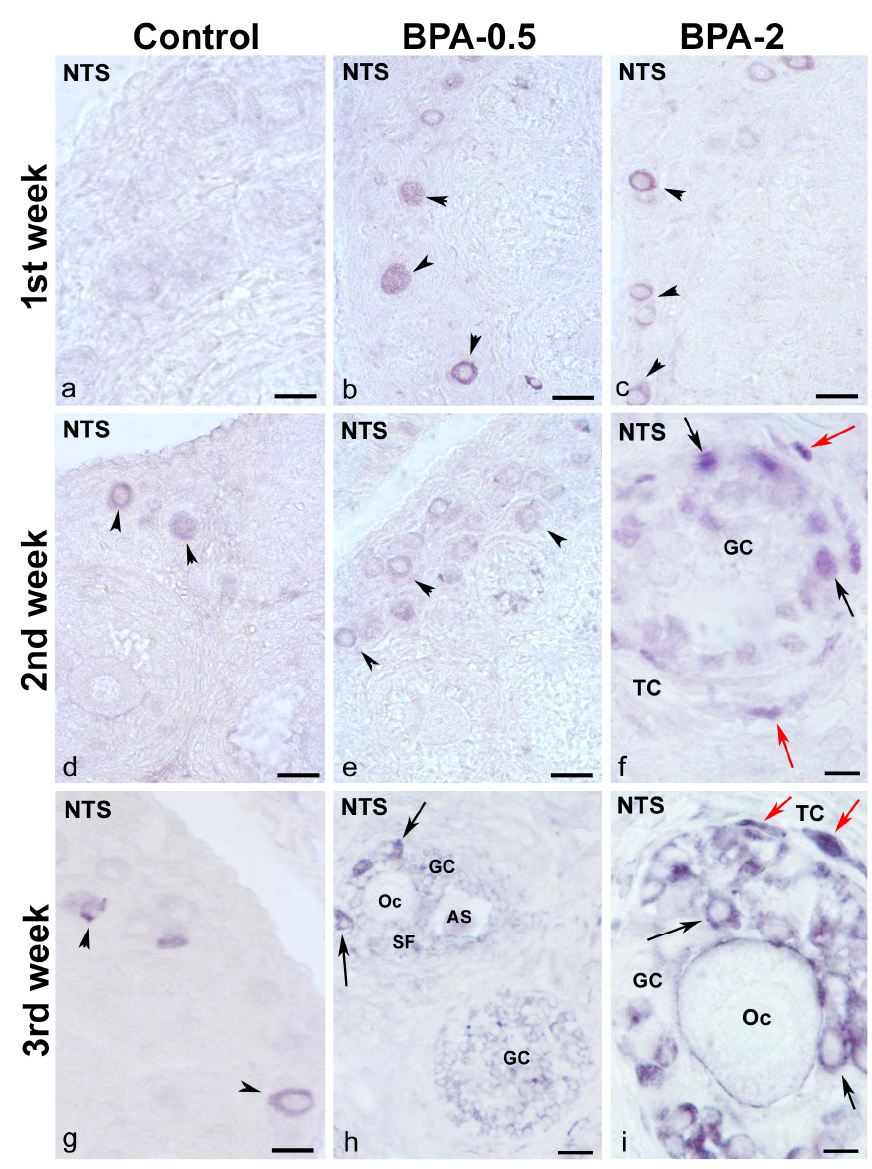
Figure 8. NTS immunoreactivity in offspring ovaries . Representative images of the ovary in the three experimental groups in the first three weeks of postnatal life showing the presence of NTS-ir in oocytes from primordial and primary follicles (arrowheads) ( a – e , g ) as well as in granulosa cells from multilayered primary ( f , i ) and secondary ( h ) follicles (black arrows) and in theca cells (red arrows). AS: antral space; GC: granulosa cells; Oc: oocyte; SF: secondary follicle; TC: theca cells. Scale bars: ( a – e ): 40 µm; ( f ): 12 µm; ( g ): 30 µm; ( h ): 15 µm; and ( i ): 10 µm.